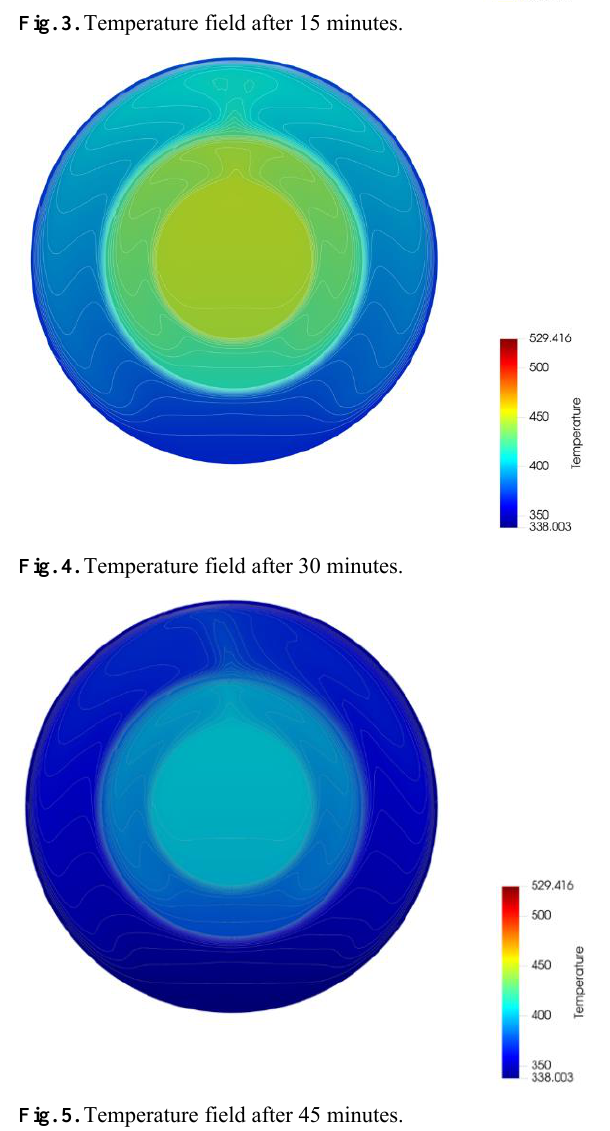
Fig. 5. Temperature field after 45 minutes .